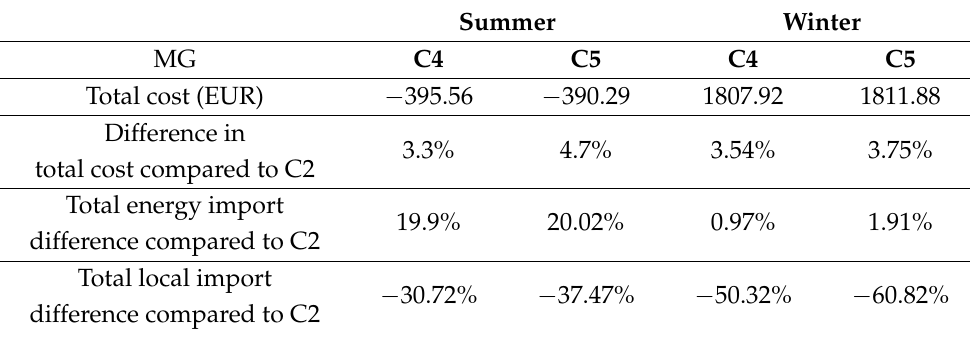
Table 5. The C4 and C5 results and a comparison to the C2